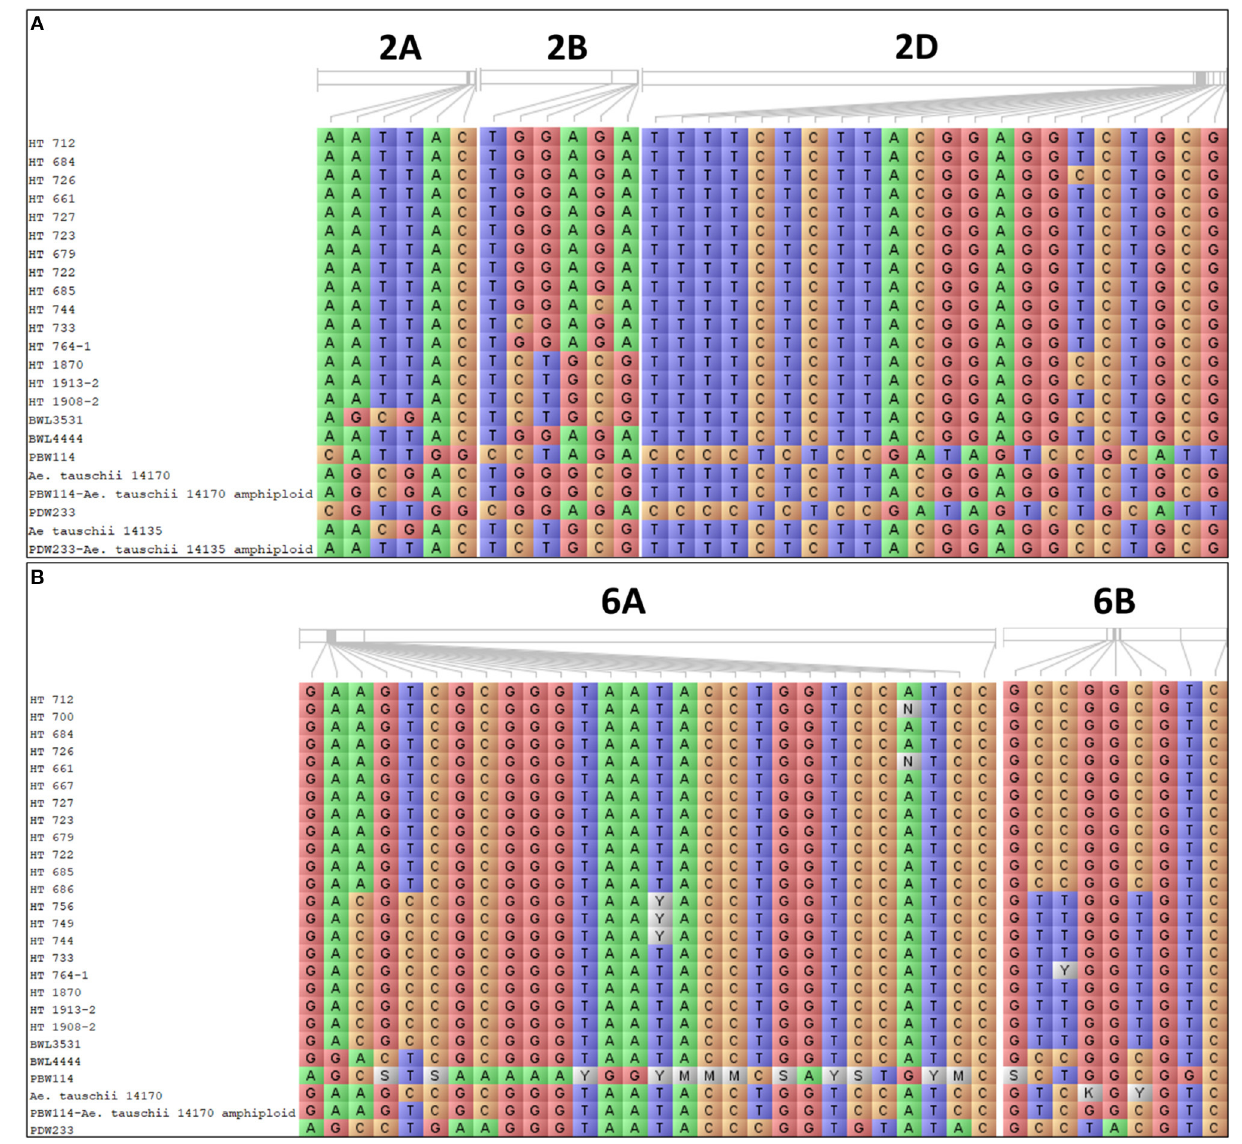
FIGURE 10 | The allelic constitution of the selected promising breeding lines, wild accessions of Ae. tauschii , cultivated and synthetic wheats for the (A) root-related traits and (B) grain yield